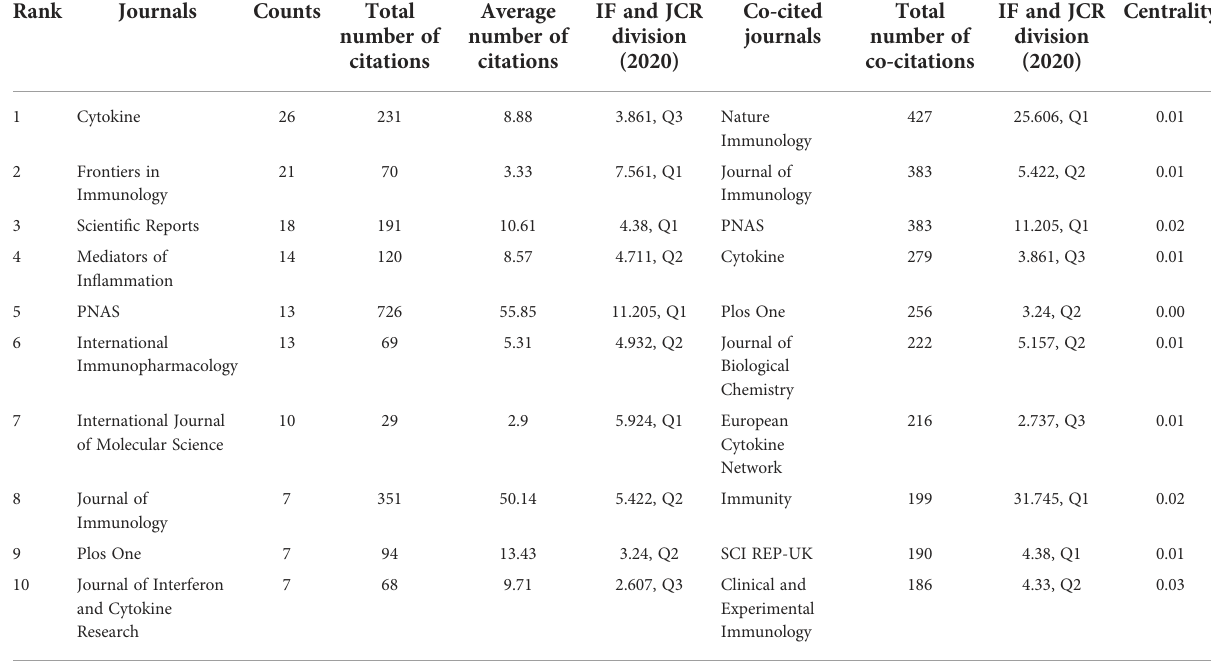
TABLE 2 The top 10 most productive journals and co-cited